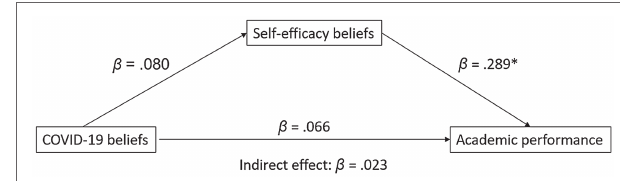
FIGURE 1 | Prediction of academic performance by COVID-19 beliefs via self-efficacy. * p <